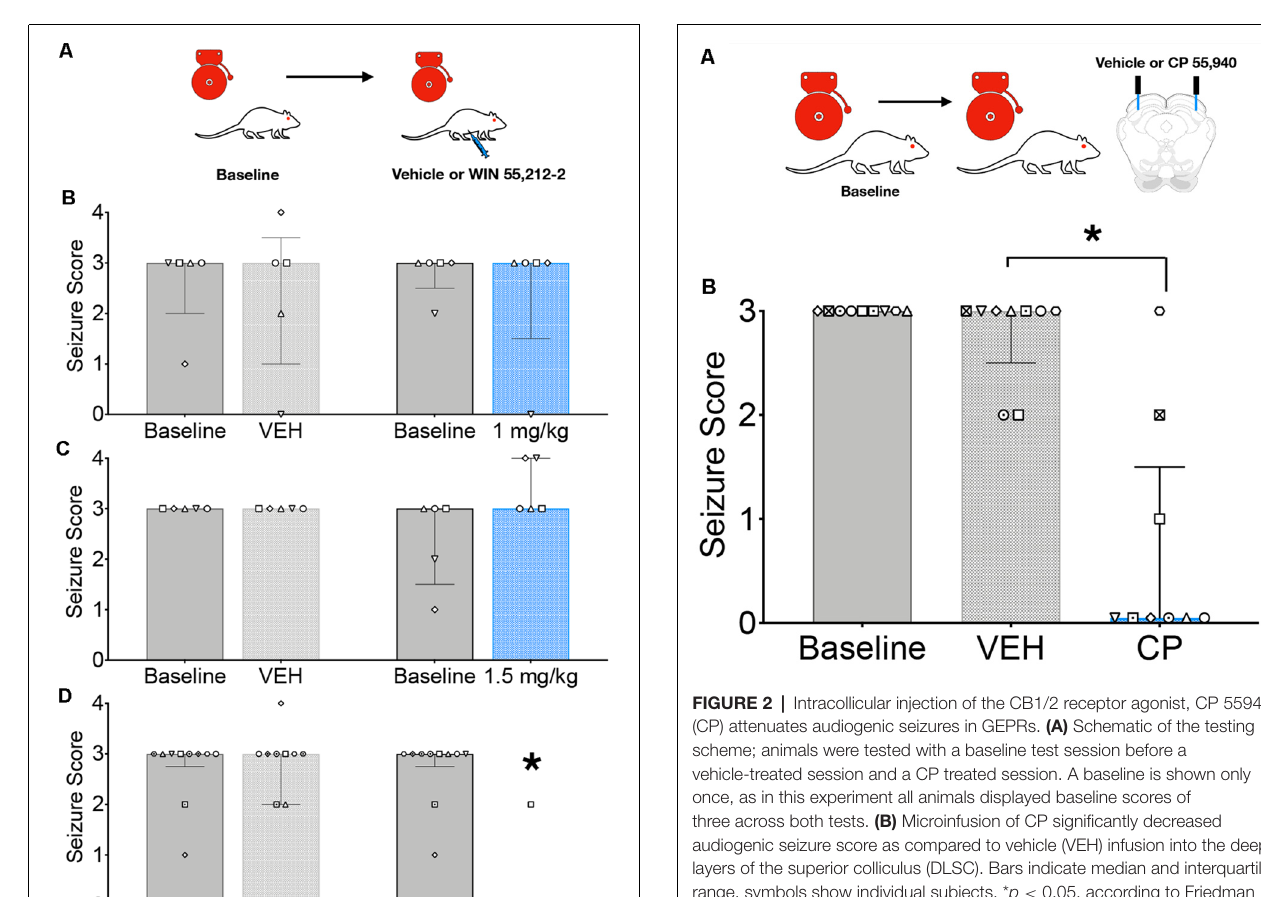
Q = 15.08, p = 0.0002; Friedman’s test, Figure 2B ).